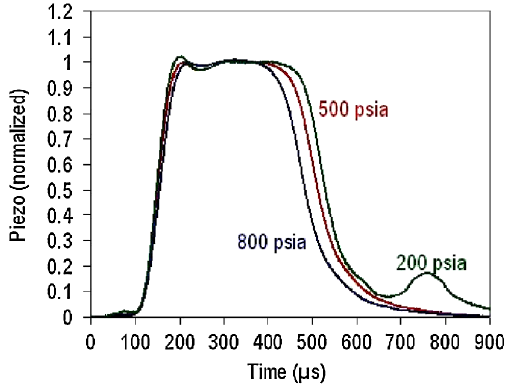
FIG. 14. Piezosensor signals at a fixed charge voltage of 350 V and different